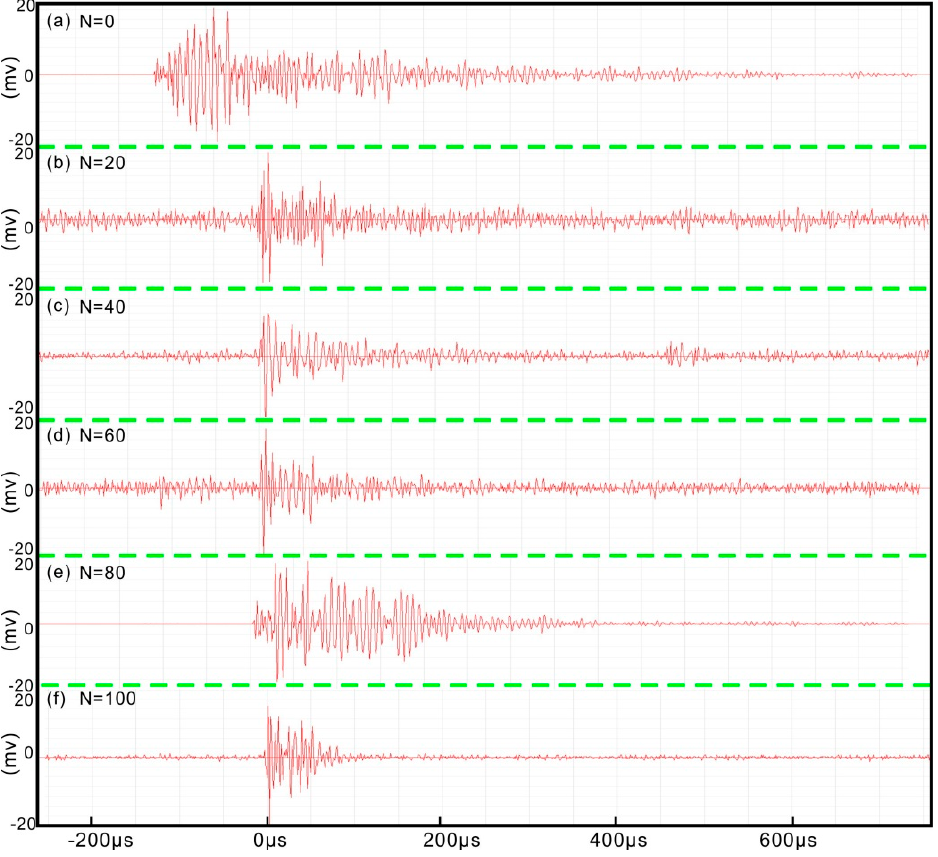
Figure 15. AE waveforms for the granite samples at their failure points. ( a – f ) The samples were subjected to 0, 20, 40, 60, 80 and 100 F–T cycles, respectively.